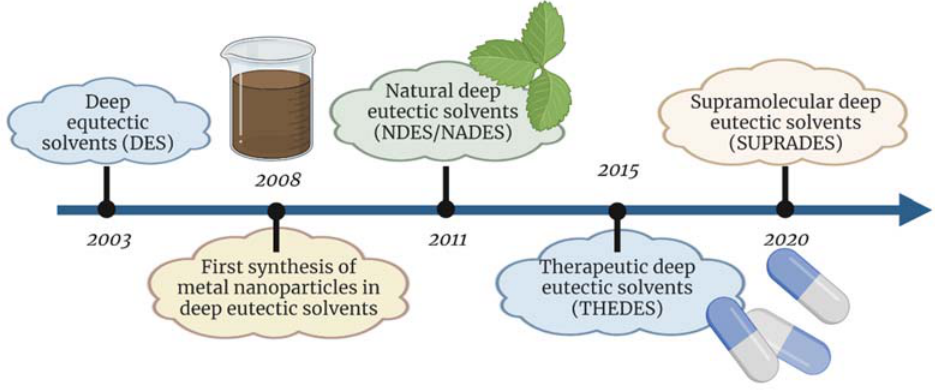
Figure 1. Historical milestones of deep eutectic solvents (created with BioRender.com).